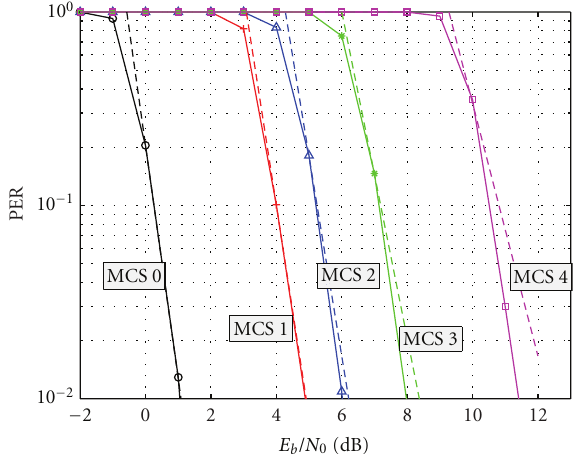
Figure 11: Parameters tuning for PER